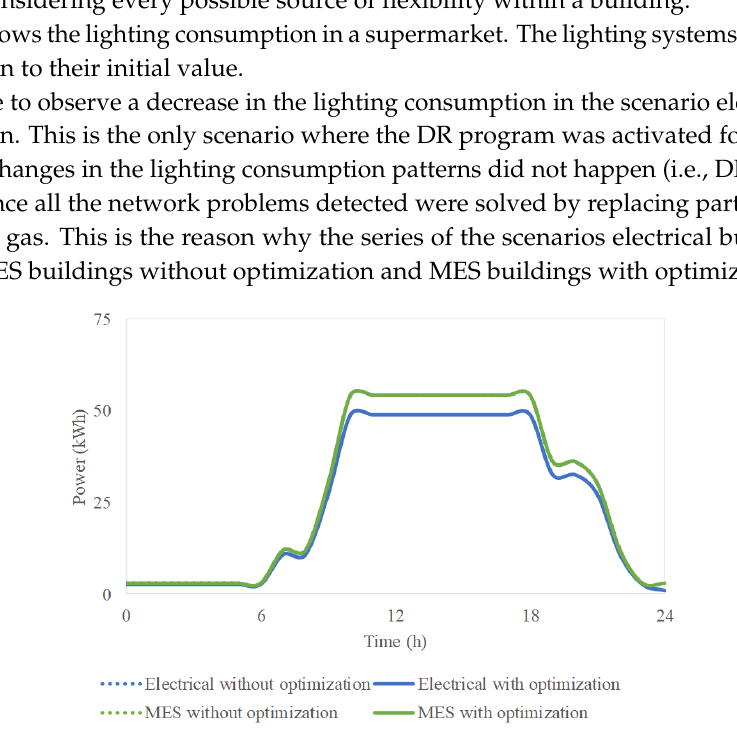
Figure 14. Power consumed for lighting in the